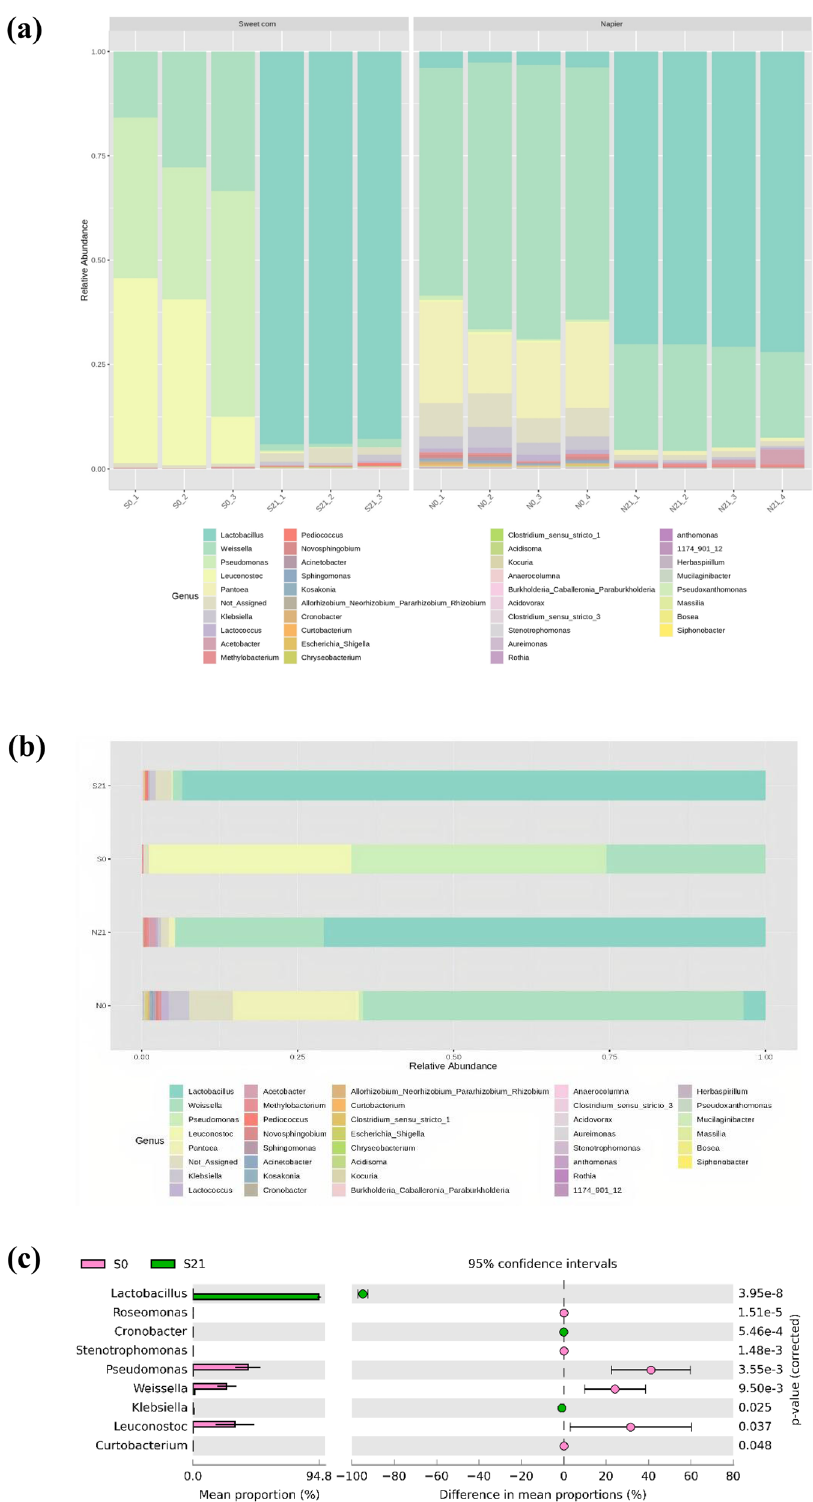
Figure 2. Composition of bacterial communities before and after ensiling using unrarefied sequences at genus level: (a) each sample, (b) group sample, (c) extended error bar comparing fresh sweet corn (S0) and sweet corn silage (S21), (d) extended error bar comparing fresh Napier (N0) and Napier silage (N21) and (e) extended error bar comparing S21 and N21 using t-test at p- value <